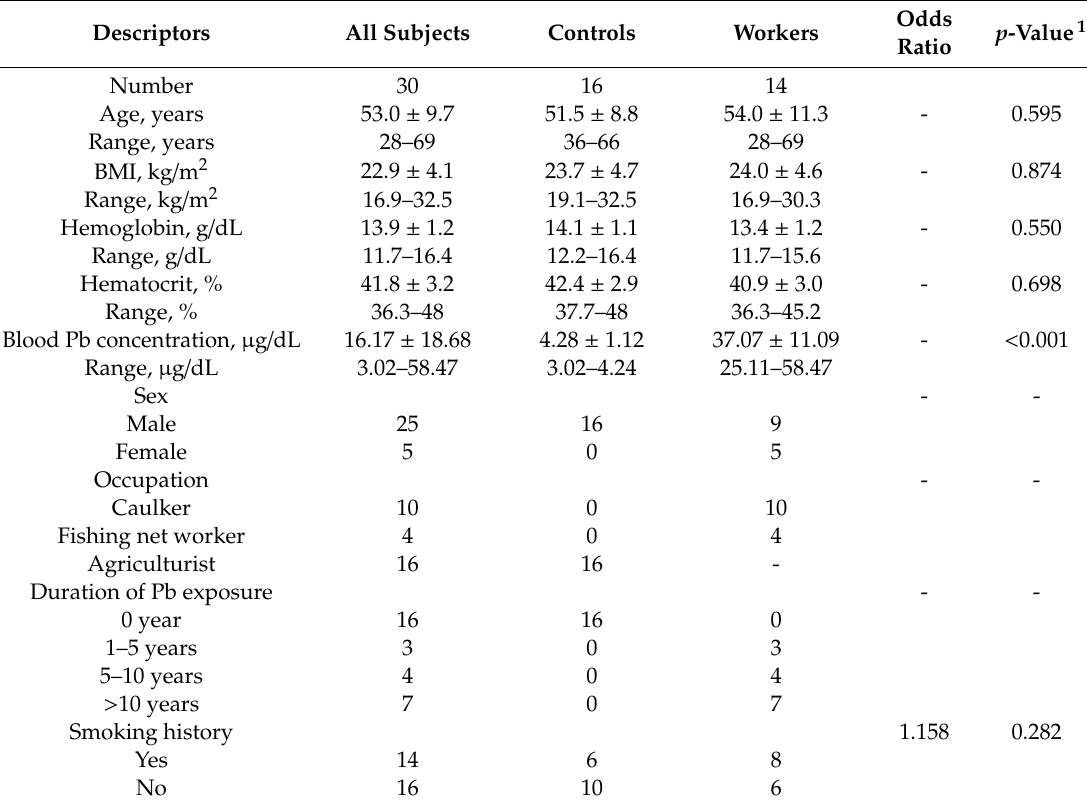
Table 1. Demographic data of control and worker groups.